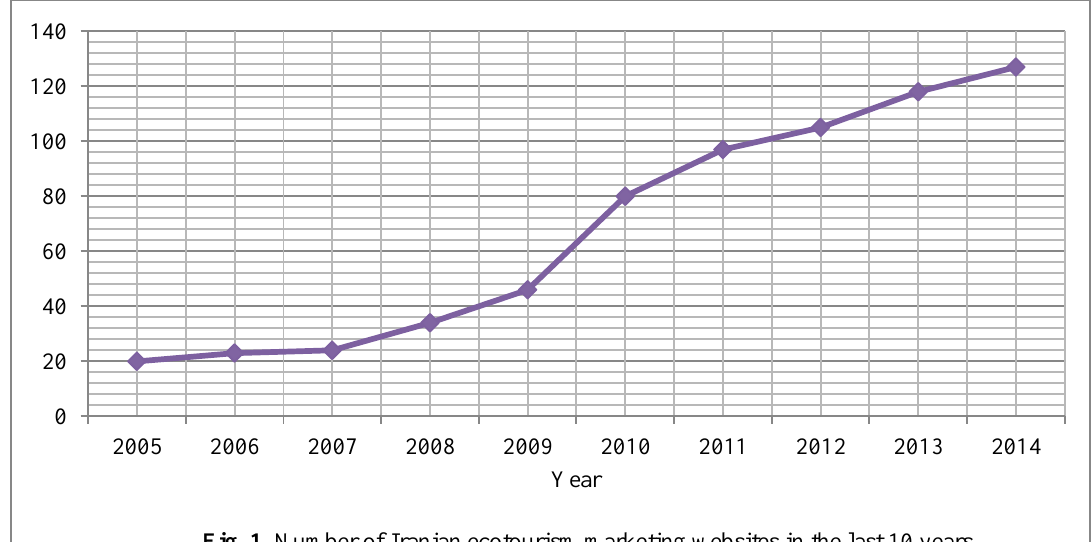
Fig. 1. Number of Iranian ecotourism marketing websites in the last 10